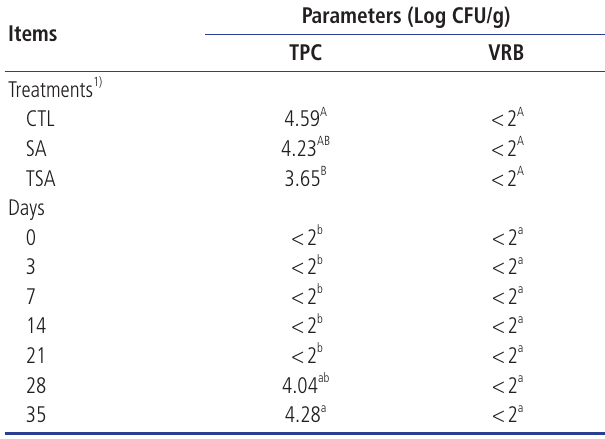
Table 4. Microbial counts of low-fat pork sausages wrapped with SA and TSA films